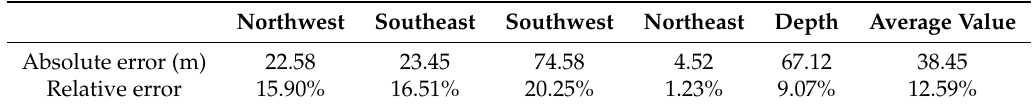
Table 4. Errors of calculated